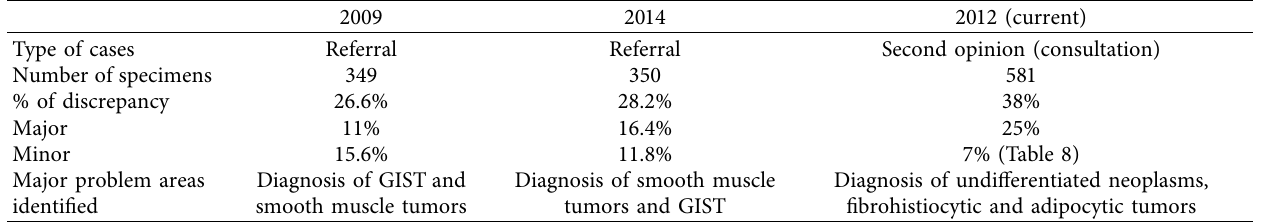
Table 10: Tumor groups causing major differences in opinion/difficulties between referral and consultation